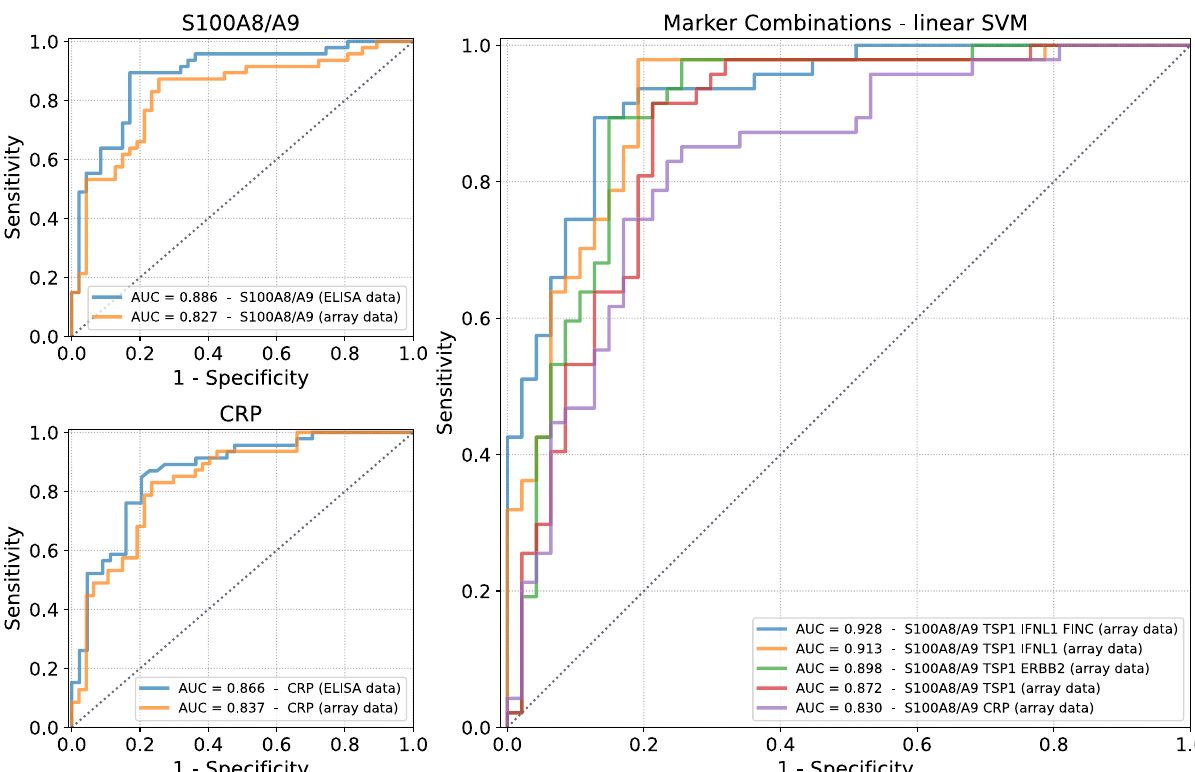
Fig. 7 Estimation of diagnostic accuracy for disease severity prediction. For the individual protein biomarkers S100A8/A9 and CRP, ROC curves of ELISA data as well as coherent multiplex antibody array data were aligned. Marker combinations of 2 – 4 proteins were selected from linSVM models, which outperform the individual biomarker candidates and exhibit a high accuracy with an AUC of up to 0.928. Area under the ROC curve (AUC) is presented for each biomarker or combination.